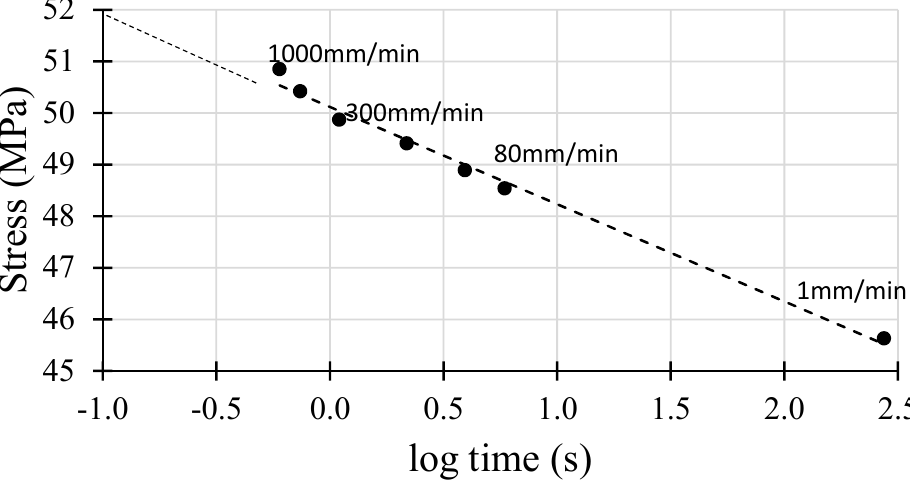
Figure 5. Tensile test results for extrapolation at 0.1 s (or log( − 1)) to find an equivalent σ max at 0.5 cycle failure. The tensile stress-strain curves obtained at different crosshead speeds are shown in Figure 6. Elastic moduli at 1 and 80 mm/min were measured to be both 1556 MPa and the lowest elastic modulus was measured to be 1333 MPa at a crosshead speed of 1000 mm/min. As such, they appear not to be much affected by the crosshead speed.